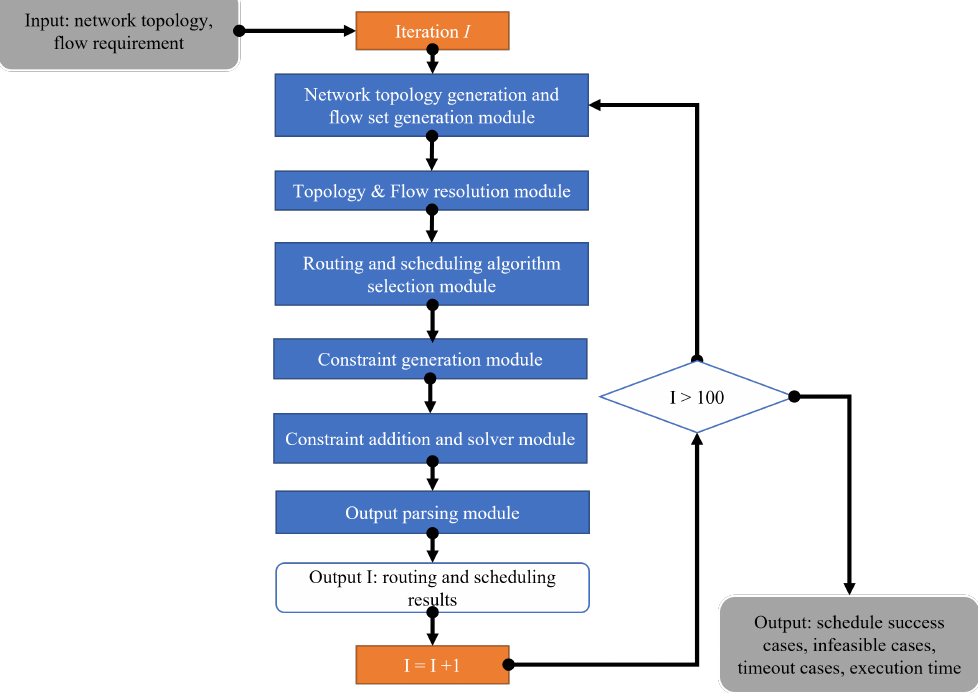
Figure 5. The overall workflow of